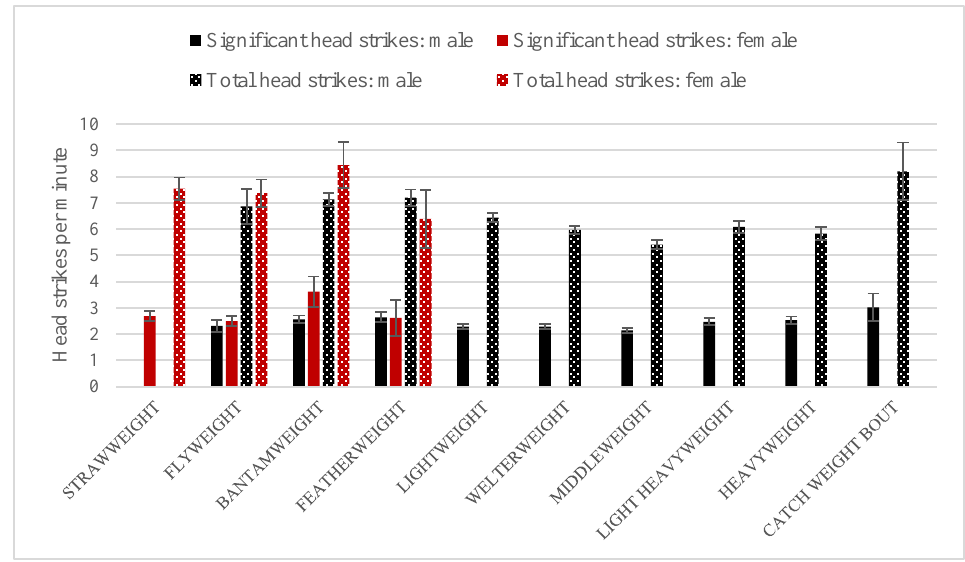
Figure 2. The number of significant (filled) and total (dotted) head strikes per minute in male (black) and female (red) fights. The error bars present standard errors.